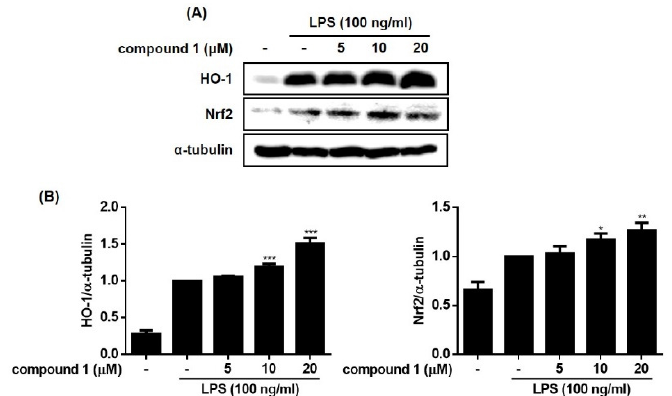
Figure 7. Effects of compound 1 on Nrf2/HO-1 pathway in LPS-induced RAW264.7 cells. The RAW264.7 cells were pretreated with the compound (5, 10, and 20 µM) for 1h before exposure to LPS for 24 h. The representative blots ( A ) and the calculated intensities after normalization to α -tubulin ( B ) were presented. Results are presented as the mean ± standard deviation from three independent experiments. The results differ significantly from LPS-only treated; * p < 0.05, ** p < 0.01, and *** p < 0.001.